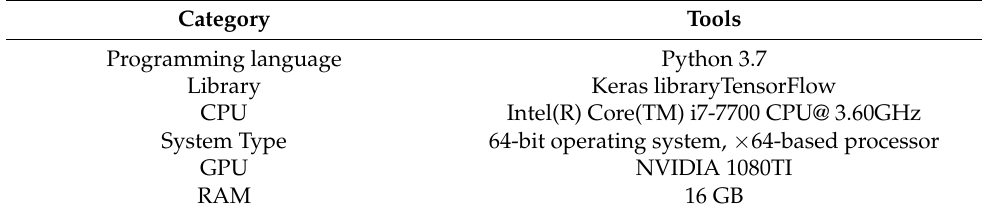
Table 4. Hardware and software resources